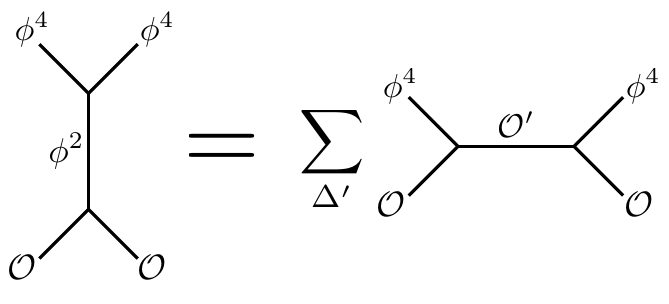
Figure 19 . Schematic bootstrap diagram showing the relation between the UV divergence at second-order in perturbation theory and the sum over intermediate states. The UV divergence comes from the contribution of φ 2 to the OPE φ 4 × φ 4 (left), and is reproduced by the infinite sum of primary operators in the O × φ 4 OPE (right). Truncating the sum by ∆ cutoff for the OPE